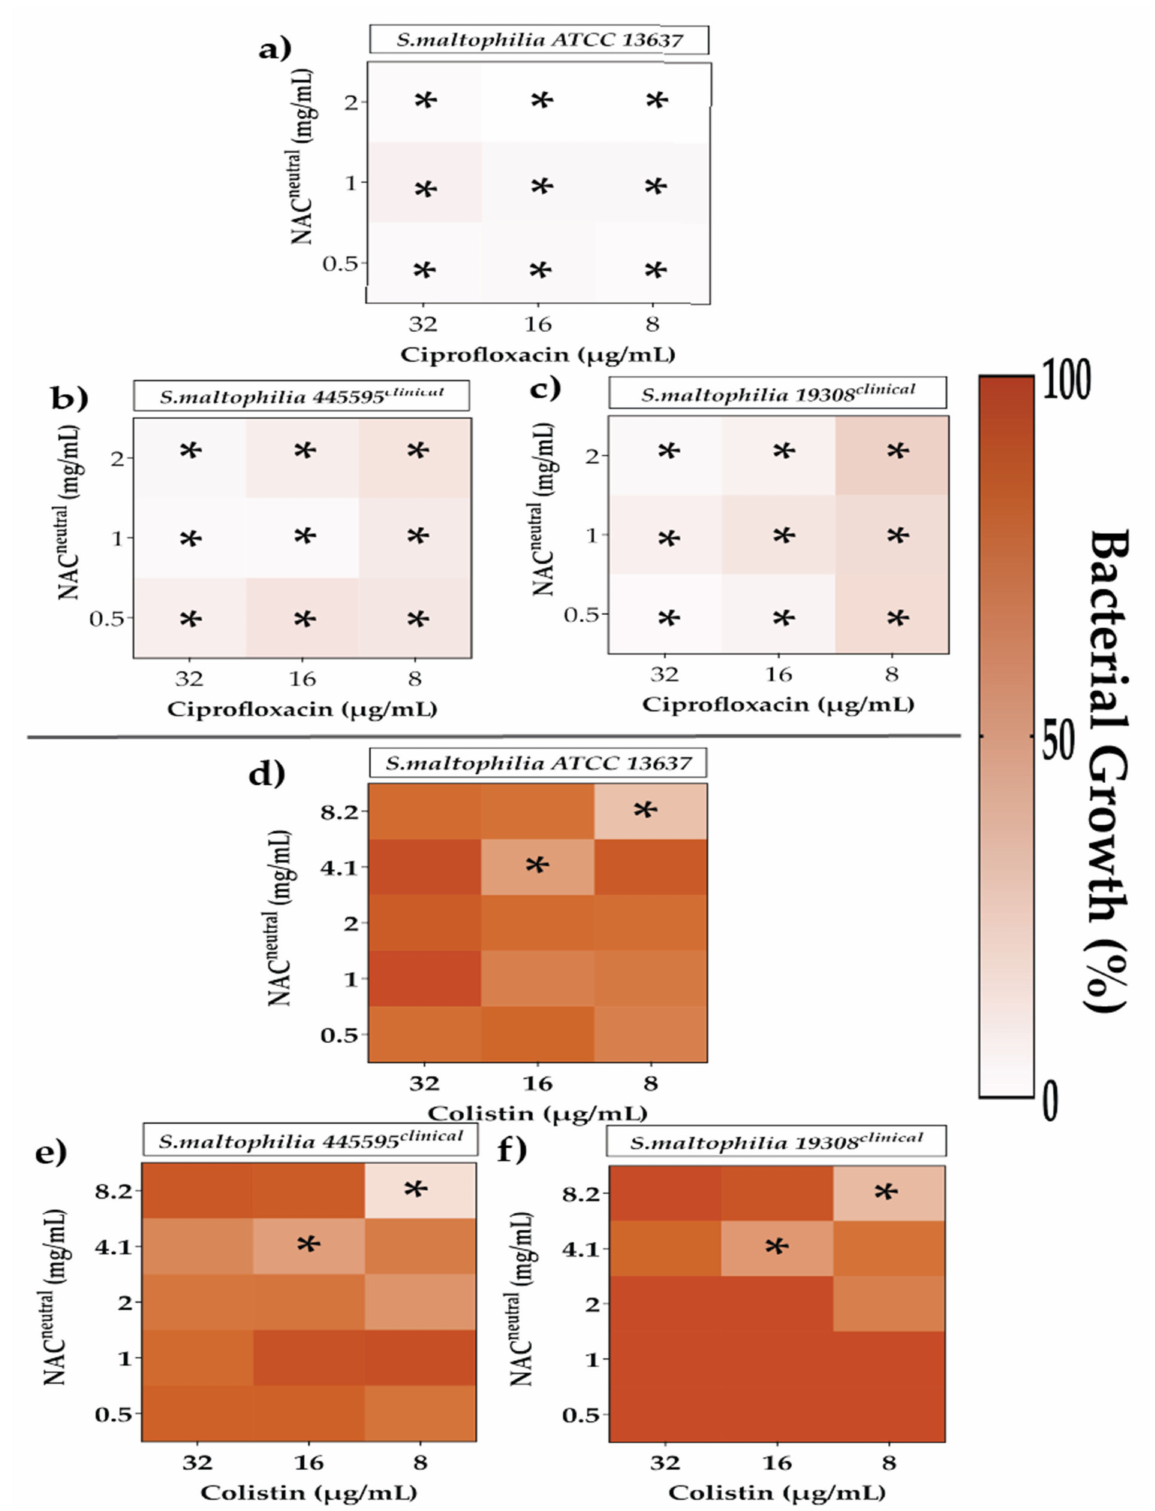
Figure 6. The effect of chosen synergistic and additive combinations against irreversibly attached Stenotrophomonas maltophilia . Heat map representing greyscale-coded planktonic bacterial growth where black represents 100% bacterial growth and white represents 0% irreversibly attached planktonic bacterial growth. Irreversibly attached bacterial growth has been measured in the presence of ciprofloxacin ( a – d ) and colistin ( e , f ) in combination with NAC neutral for S. maltophilia strains. Statistical analyses were performed using one sample t -test and Wilcoxon rank tests. Significance cut-offs are as follows p ≤ 0.05 ( * ). Data represent an average of n = 3 biological